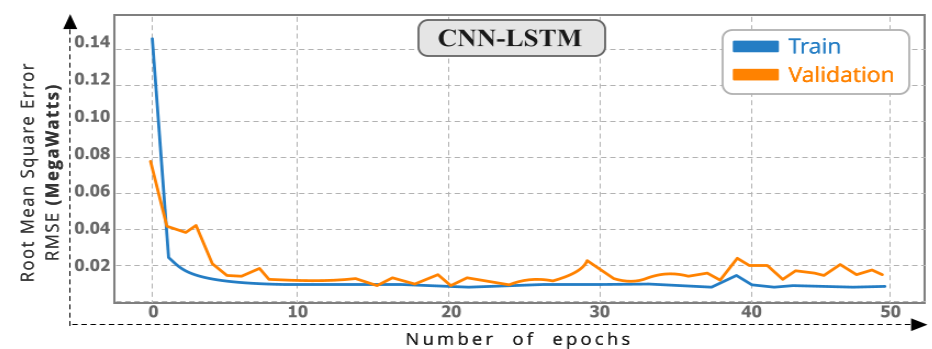
Figure 8. Hybrid CNN-LSTM loss function behavior according to the number of epochs.